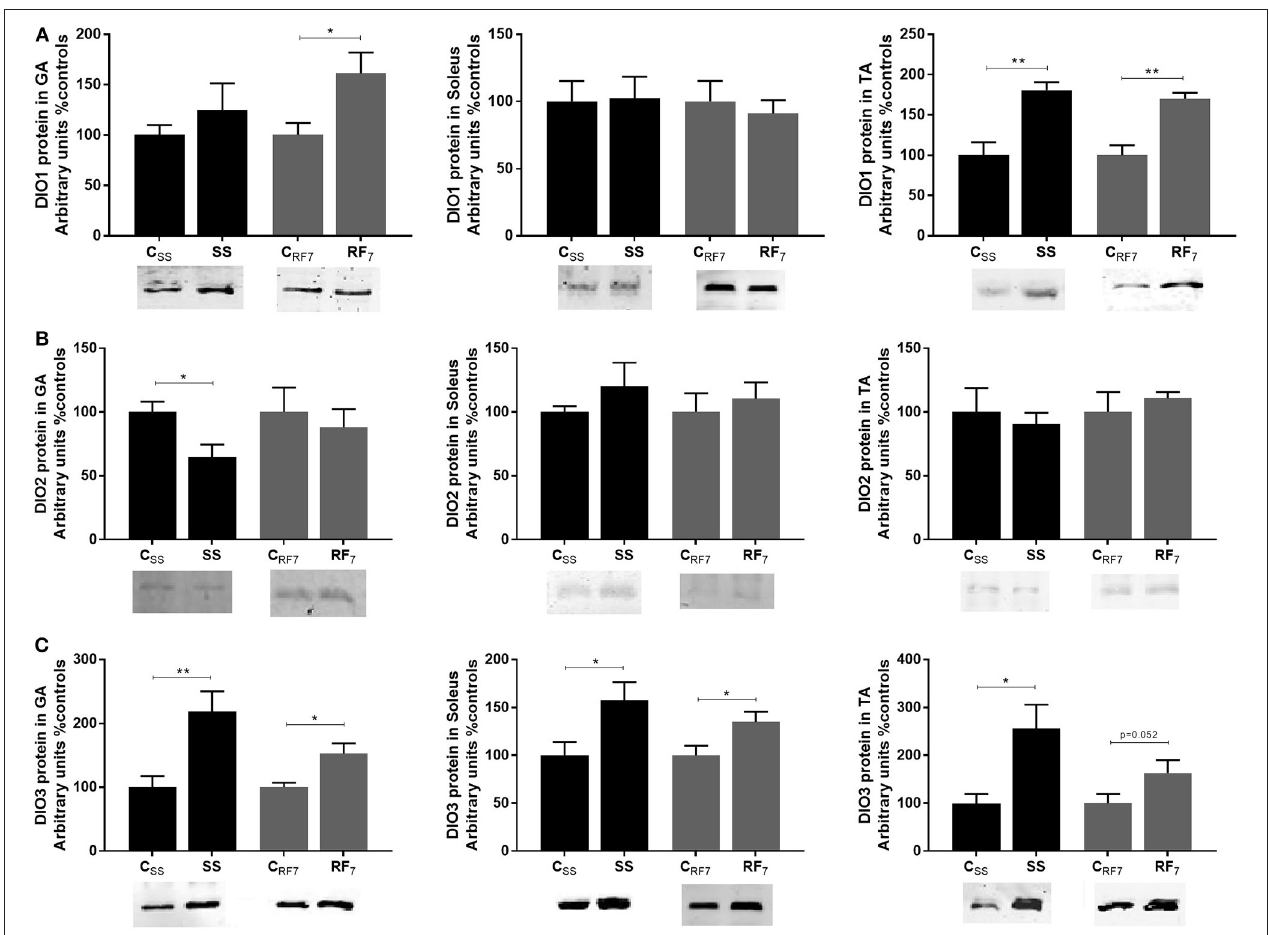
FIGURE 4 | Protein expression of the deiodinases: (A) DIO1, (B) DIO2, and (C) DIO3 in Gastrocnemius (GA), Soleus and Tibialis anterior (TA) muscles from (i) rats semistarved (SS) for 14 days and their controls (C SS ), and (ii) rats refed for 7 days (RF7) and their controls (C RF7 ). The values are mean ± SE ( n = 4). Statistical significance of differences are indicated as follows: * p < 0.05; ** p <